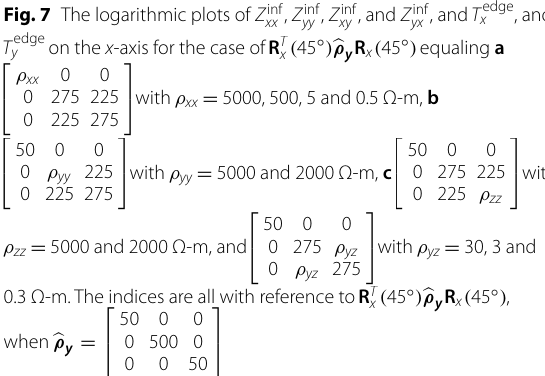
Fig. 7 The logarithmic plots of Z inf xx , Z inf yy , Z inf xy , and Z inf yx , and T edge x ,